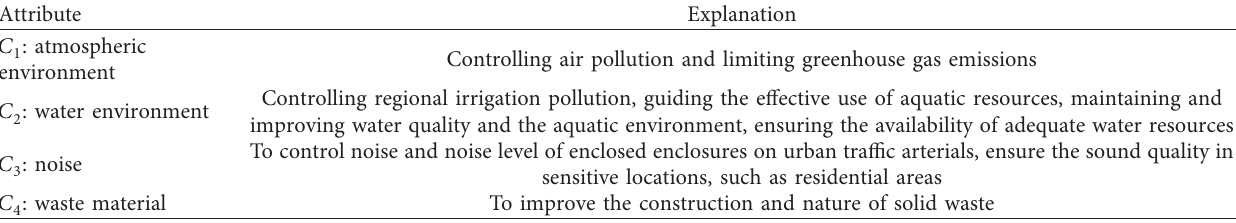
Table 5: The description of the attributes under consideration.